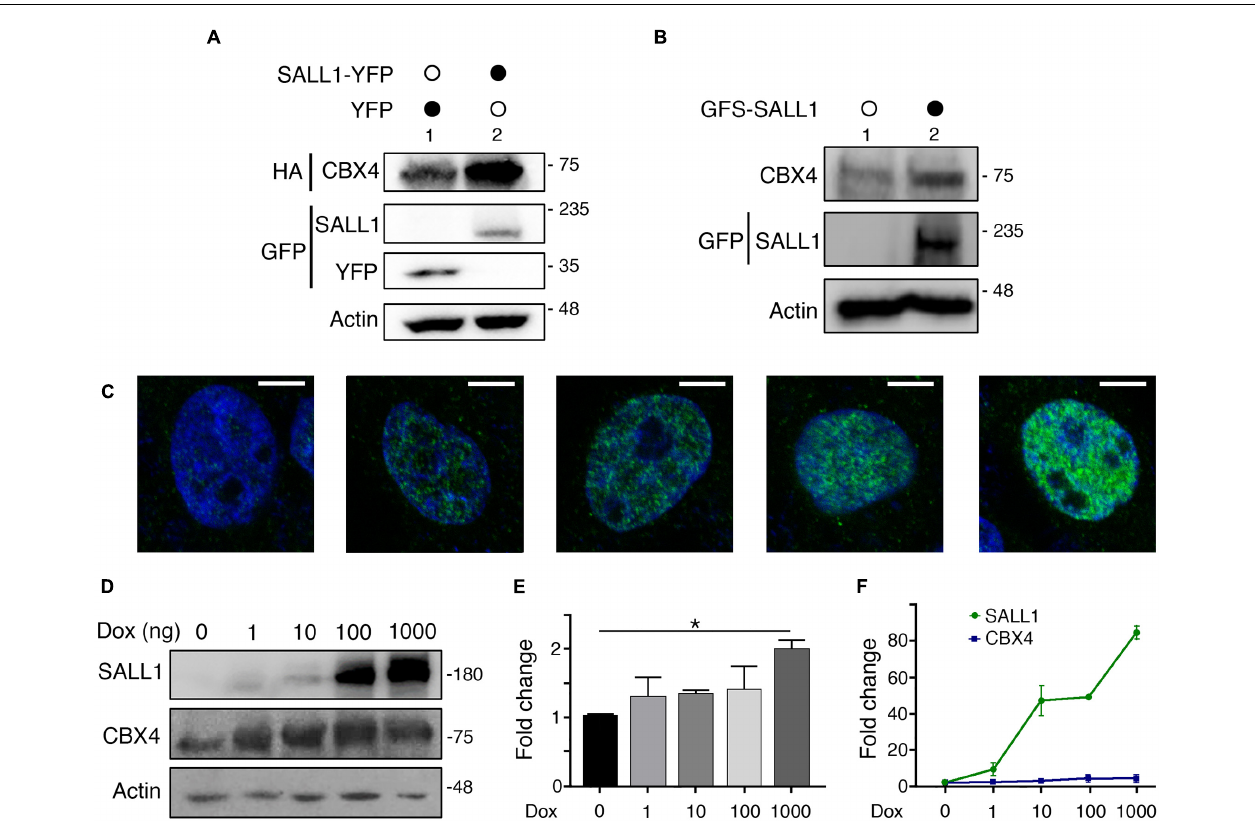
FIGURE 4 | SALL1 influences the levels of CBX4. (A) Western blot showing protein levels of CBX4-HA when co-expressed with SALL1-YFP or YFP alone in HEK 293FT cells. Actin expression was used as loading control. (B) Western blot showing expression levels of endogenous CBX4 protein in parental HEK 293FT cells (lane 1) or in HEK 293FT cells stably expressing GFS-SALL1 (lane 2). (C) Confocal microscopy images showing inducible expression SALL1-2xHA in HEK 293FT_TripZ-SALL1-2xHA cells. Cells were treated with different concentrations of doxycycline (Dox) to induce SALL1 expression as indicated. SALL1-2xHA was detected using anti-SALL1 primary antibody (green). Cell nuclei were stained with DAPI (blue). (D) Western blot analysis showing expression levels of endogenous CBX4 in HEK 293FT_TripZ-SALL1-2xHA cells treated with increasing concentrations of Dox. (E) Quantification of the expression levels of endogenous CBX4 in HEK 293FT_TripZ-SALL1-2xHA cells treated with increasing concentrations of Dox. Three independent experiments as the one shown in D were performed. The intensity of CBX4 bands was quantified using ImageJ, and the values were normalized to the levels of Actin. P -value was calculated using one-way ANOVA test. * P -value < 0.05. (F) RT-qPCR analysis of SALL1 and CBX4 mRNA expression in HEK 293FT_TripZ-SALL1-2xHA cells treated with increasing concentrations of Dox. SALL1 and CBX4 expression were normalized using GAPDH expression and shown as fold change relative to untreated control. (A,B,D) Molecular weight markers are shown to the right in KDa. Antibodies were used as indicated to the left. (E,F) The mean plus SEM of at least three independent experiments is